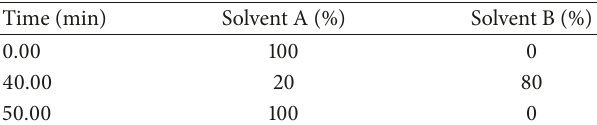
Table 1: Mobile phase gradient used for determination of secondary